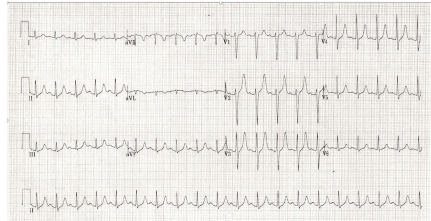
Figure 1: ECG displaying sinus tachycardia.